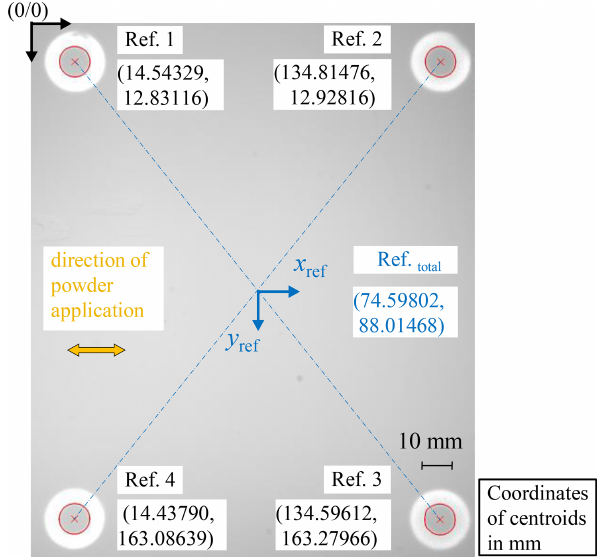
Figure 7. Canny contour evaluation of reference